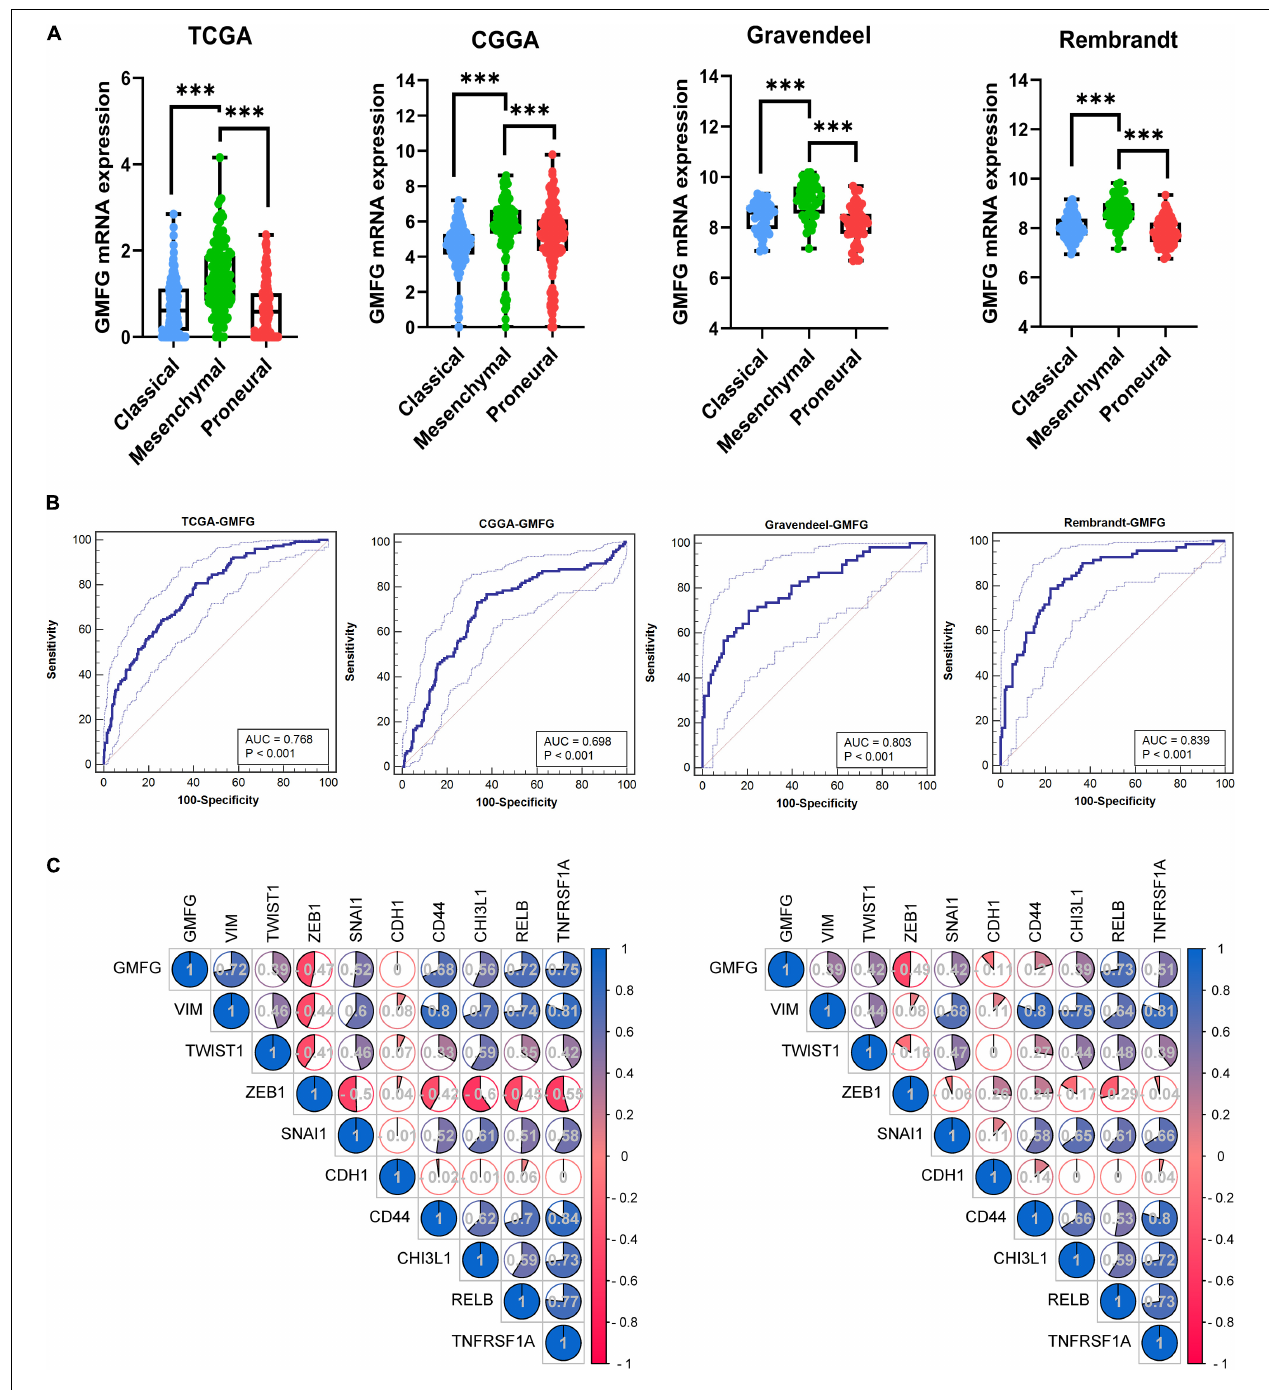
FIGURE 3 | Glia maturation factor- γ expression associated with GBM subtypes. (A) GMFG expression in different subtypes of GBM in the TCGA, CGGA, Gravendeel, and Rembrandt datasets. CL, classical; ME, mesenchymal; PN, proneural. ∗∗∗ P < 0.001. (B) Accuracy of GMFG to predicting ME subtype as determined using ROC curves. ROC, receiver operating characteristic; AUC, area under the curve. (C) Spearman correlation method was employed to analyze the correlation coefficient between GMFG and mesenchymal-related genes in TCGA and CGGA.